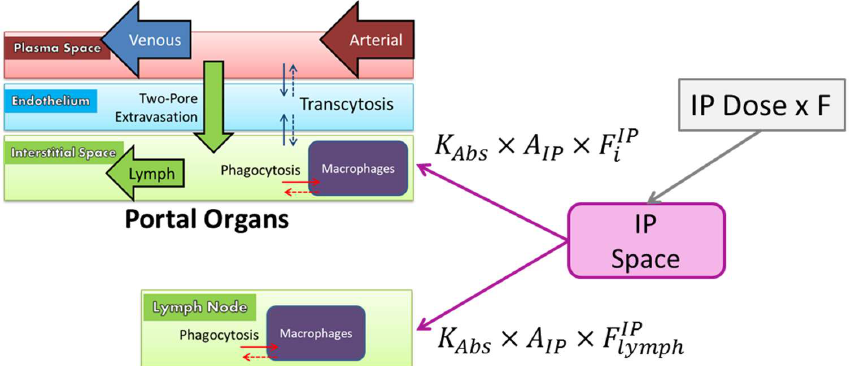
Figure 3. Schematic depicting the intraperitoneal (IP) injection route of administration. A fraction of NPs diffuses from the IP space into the interstitial spaces of the portal organs and lymph node before reaching systemic circulation.